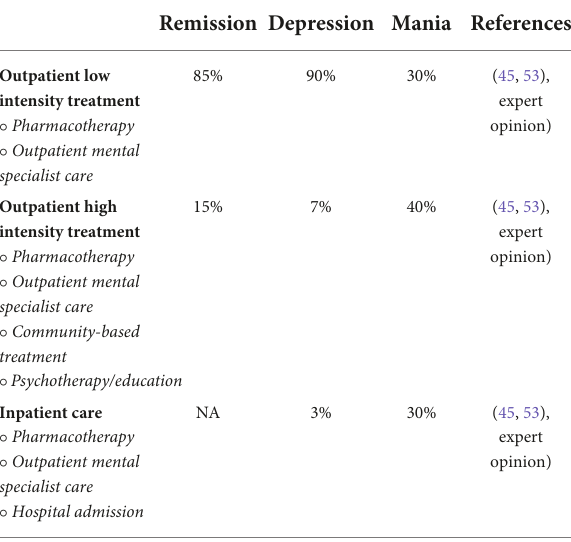
TABLE 2 Treatment components of the standard of care per health state included in